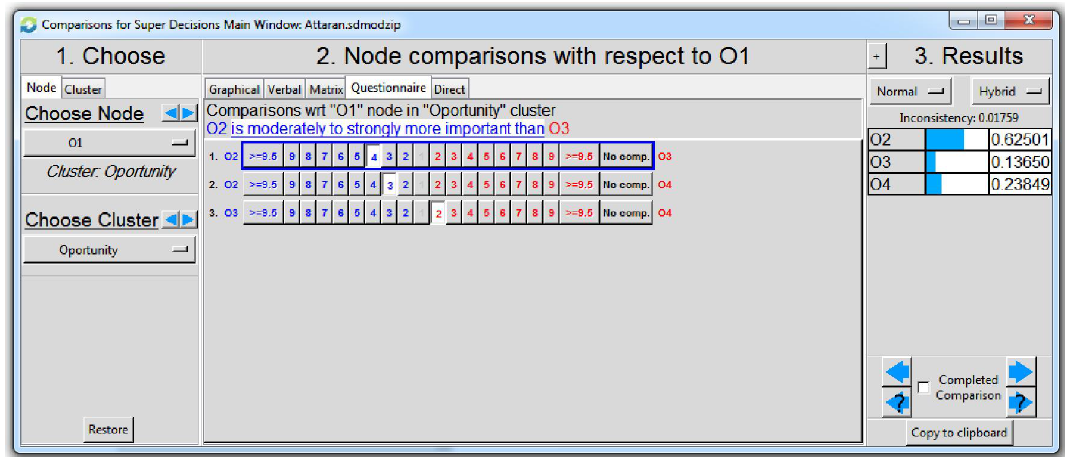
Fig. 4. Input/output of factors associated with opportunities